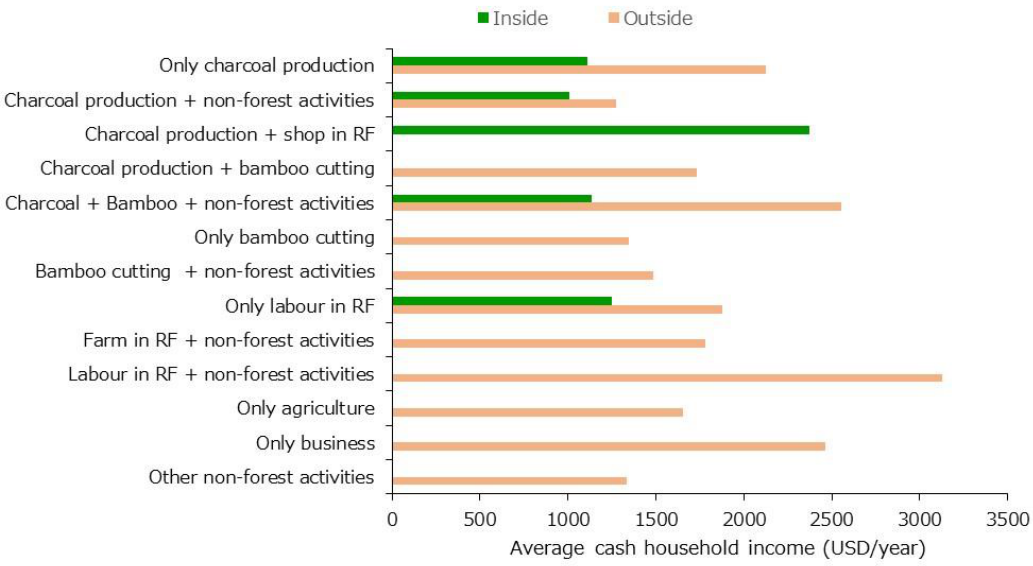
Figure 3. Average household cash income (USD/year) for each of cash income strategies.